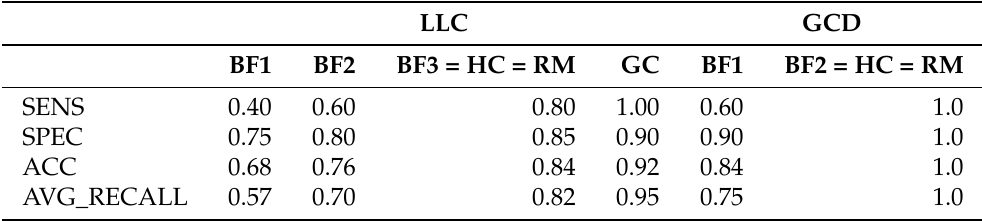
Table 8. Granger causality (GC) and Bayes networks (brute force networks (BFi) and hill climbing (HC)) performances with respect to the synthetic (Table 7) data sets LLC and GCD.